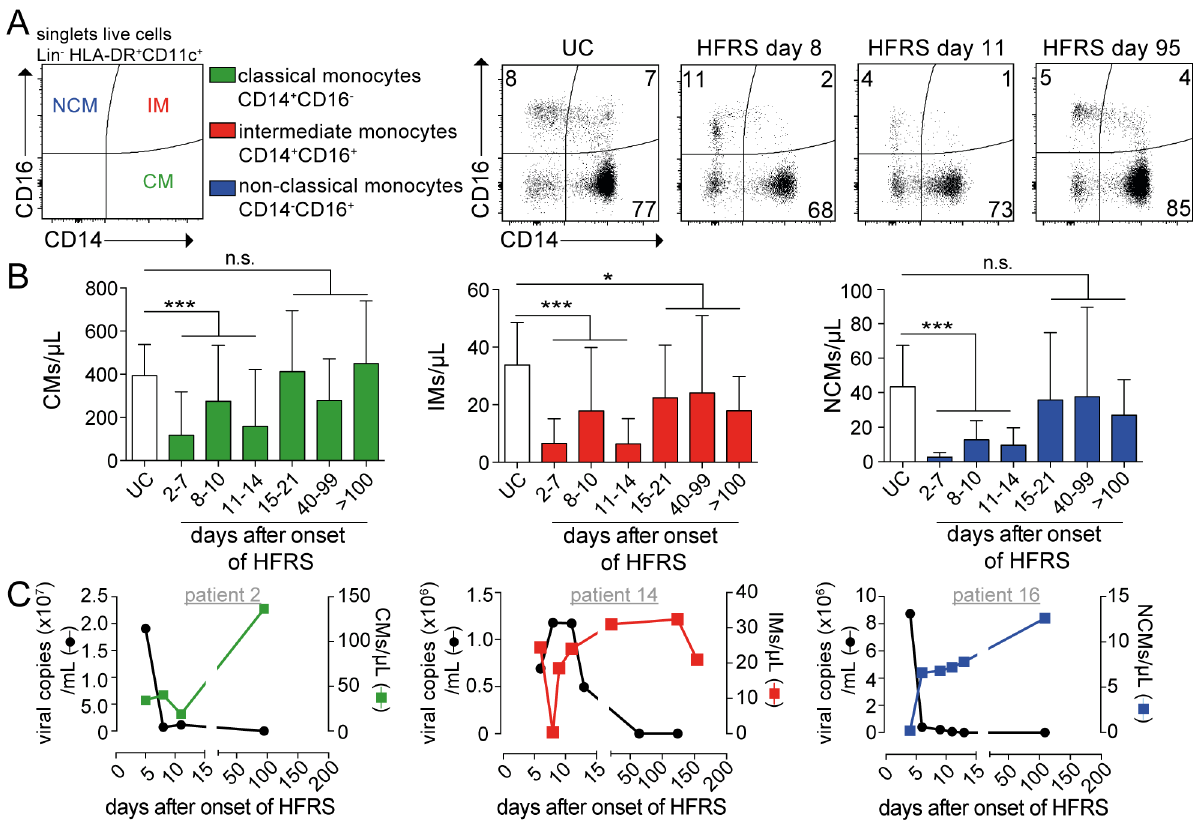
Fig 3. Reduction in absolute numbers of human monocytes in circulation during acute HFRS. (A) Gating strategy for the identificationof classical monocytes(CM, green), intermediatemonocytes (IM, red) and non-classical monocytes(NCM, blue) by flow cytometry after gating out lineage(CD3, CD20, CD56) cells and gatingon HLA-DR + , CD11c + cells. Representative flow cytometry plots from one representative UC and HFRS patient are shown. (B) Mean ± SDabsolutenumbers of monocyte populationswere evaluatedin longitudinalsamples in HFRS patients. (C) Graphs show detectableviral load in plasma measuredby viral RNA quantification from one representativeHFRS patient. Virologicaldata (left axis; black line) and absolutenumbers of monocytes (right axis; colored line) plotted over time from one representative HFRS patient. Differences in mean absolute numberof monocyteswere assessedusing Poissonregression: *** p < 0.001,n.s. not significant.